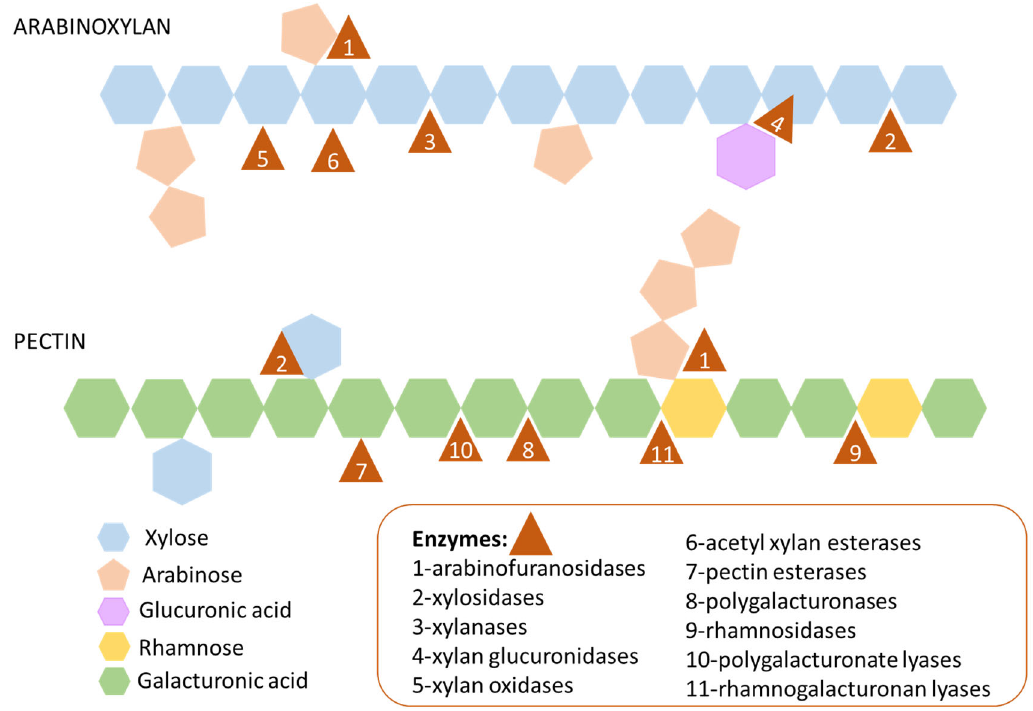
Figure 2. Schematic representation of enzyme domains acting on arabinoxylan and pectin that were annotated in metagenome-assembled genomes (MAGs) recovered from the microbiota of patients with Crohn’s disease and healthy individuals.